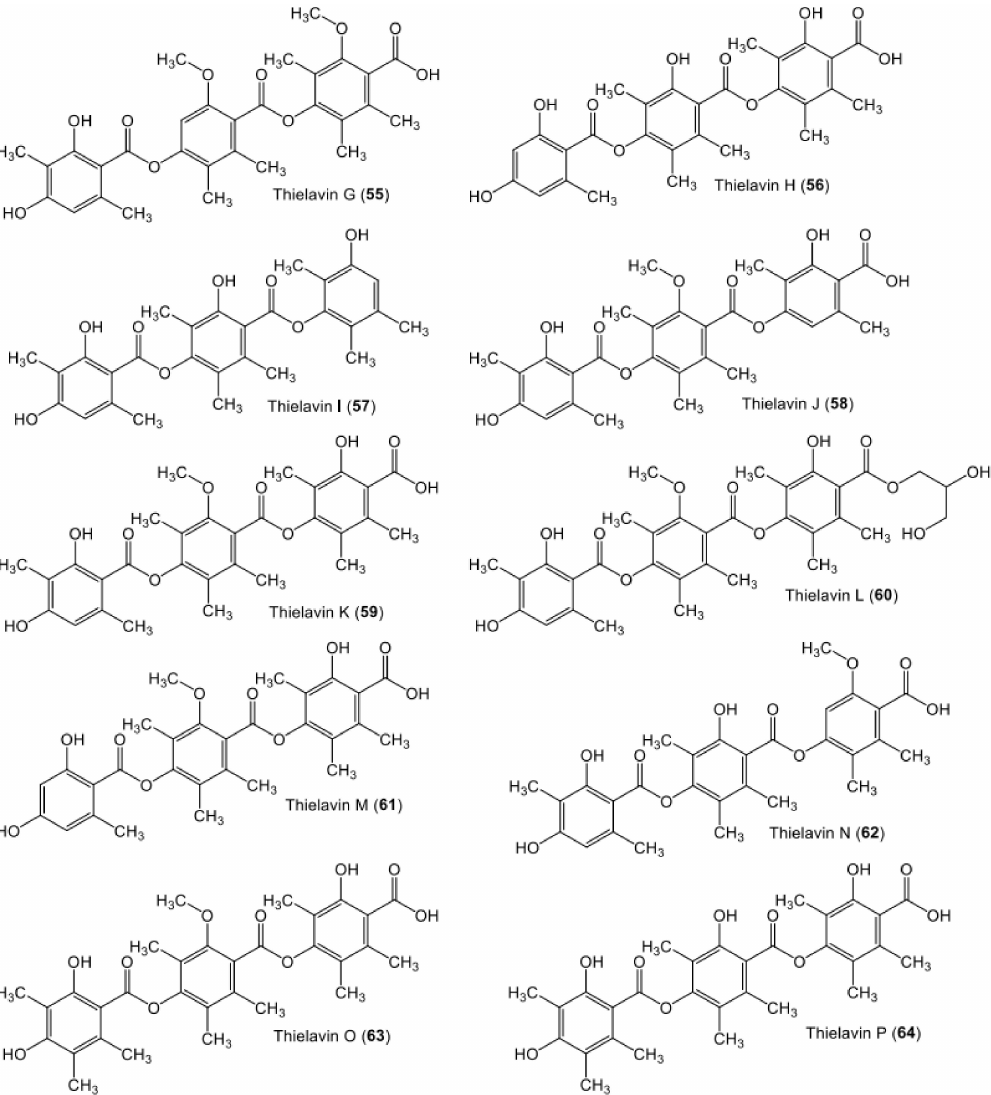
Figure 9. Chemical structures of tri-depsides 55 – 64